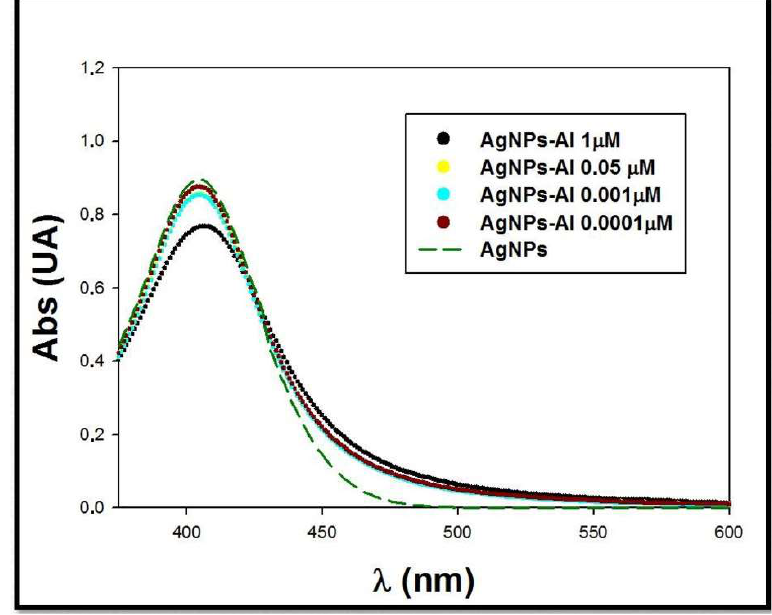
Figure 4. Spectra of mixtures citrate + PVP-AgNPs:Al. C Citrate + PVP-AgNPs = 7.6 × 10 − 15 M. C Al(III) = 1–1 × 10 − 4 µ M.